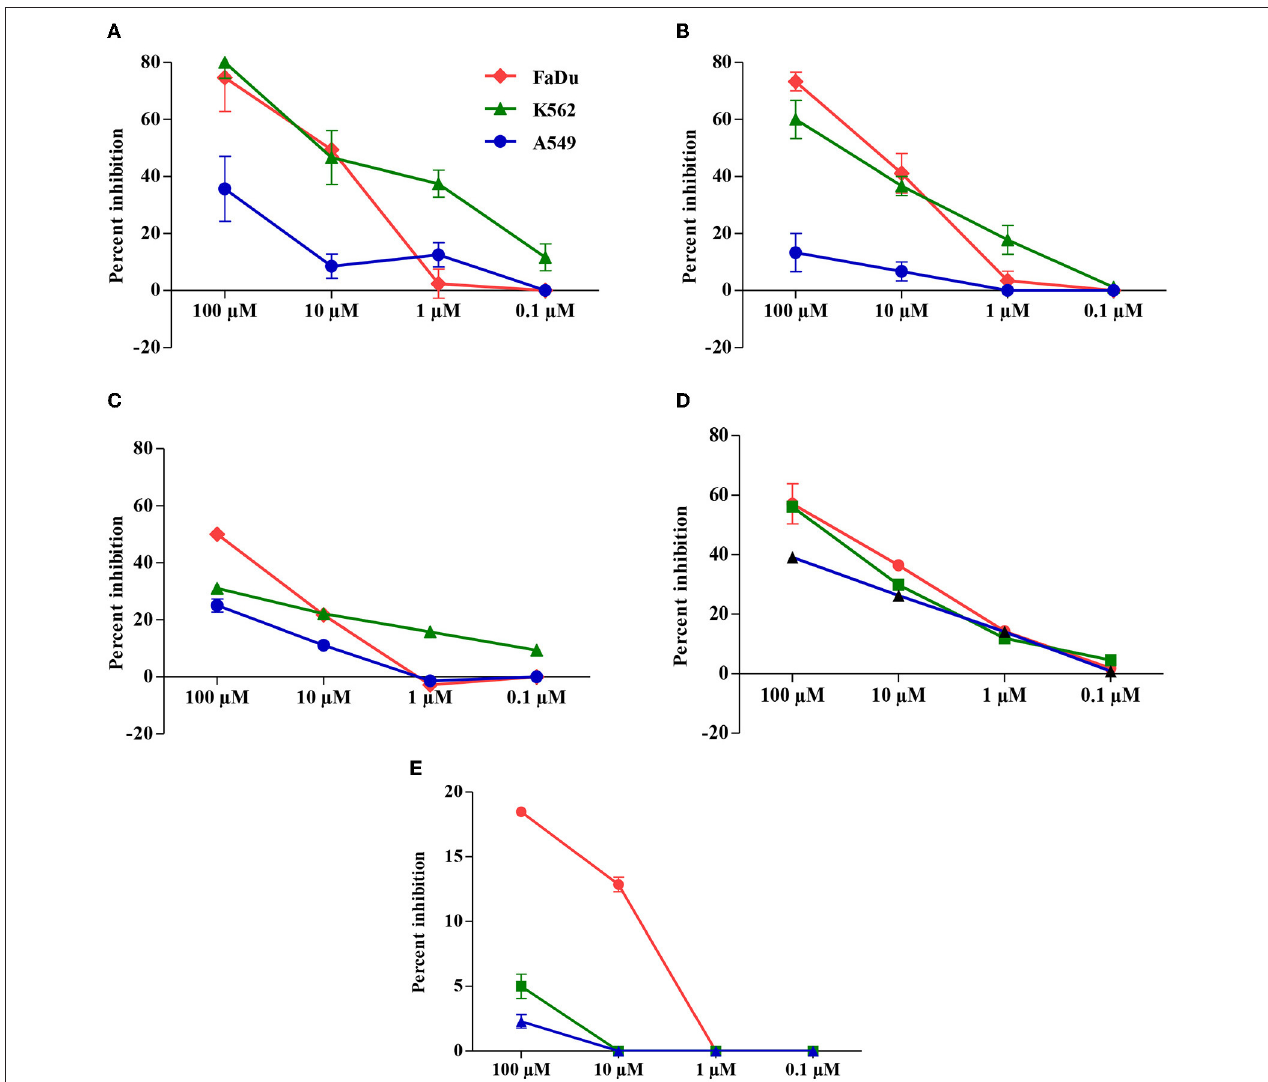
FIGURE 2 | Carvacrol modulates the activity of cancer targets in a FaDu, K562, and A549 cell lines. Treated cancer cell lines were determined by the protocol described in materials and methods section. (A) Suppression of ornithine decarboxylase (ODC) activity by carvacrol. (B) Destruction of cyclooxygenase-2 (COX-2) activity by carvacrol. (C) Inflection of lipoxygenase 5 (LOX-5) activity by carvacrol. (D) Modulatory effect of carvacrol on hyaluronidase (HYAL) activity. (E) The suppression of cathepsin D (CATD) activity by carvacrol. The graph is shown in percentage inhibition. Data are presented as mean ± SD ( n = 3). Comparatively, carvacrol exhibits a pronounced effect against ODC in FaDu